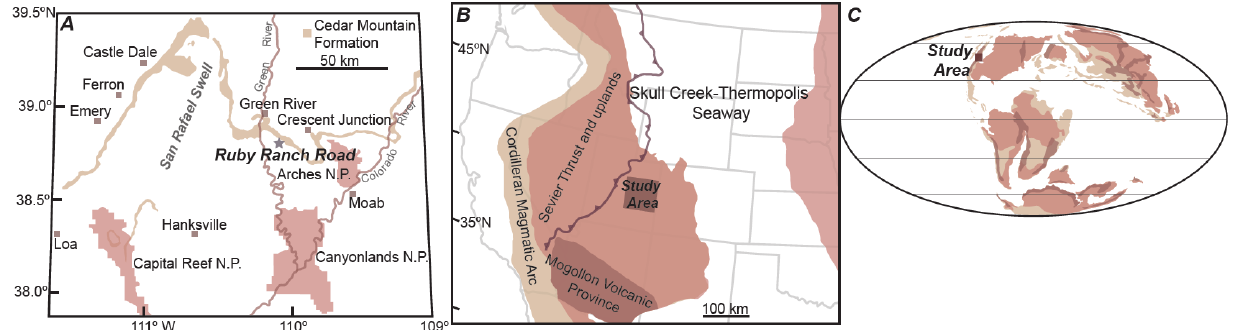
Figure 1. Maps of the field locations (after [19]). ( A ) Outcrop map of the Cedar Mountain Formation (shaded region around the San Rafael Swell and elsewhere) in present-day Utah. ( B ) Paleogeo- graphic reconstruction of the study area with respect to the Sevier Foreland Basin and the Skullcreek-Thermopolis Seaway. ( C ) Global paleogeography during the early Aptian with the location of the study area indicated by the square symbol. Color gradient reflects general areas of low–high relief (light to dark colors, respectively).